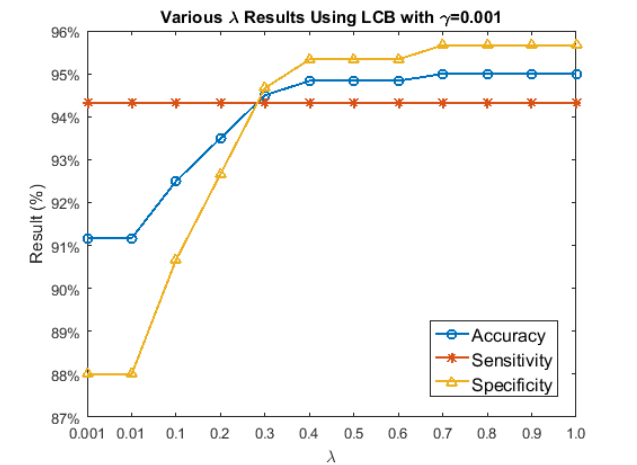
Figure 11. Various λ results of Brain Disease (BD) vs. Healthy